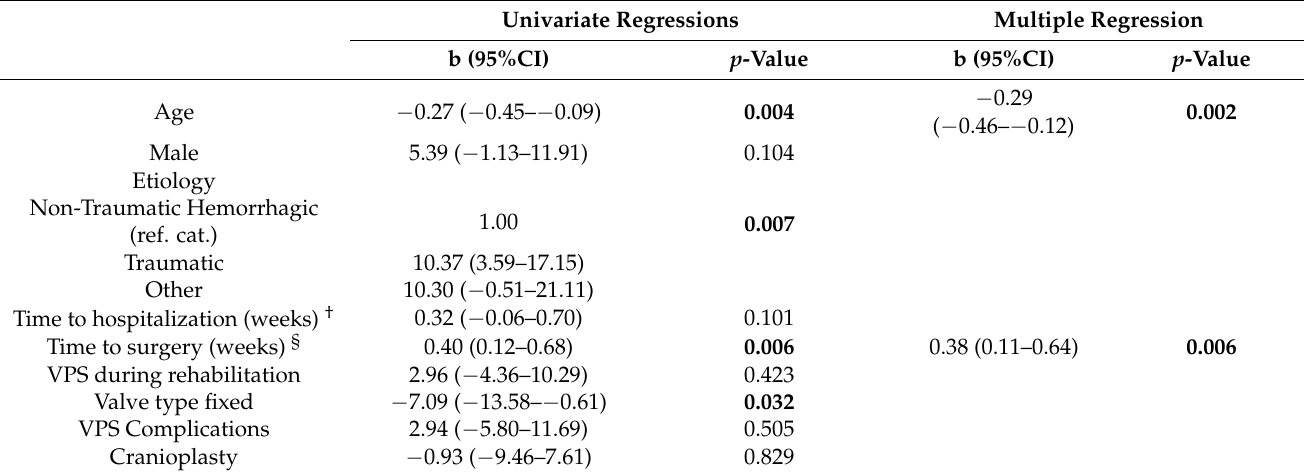
Table 3. Factors associated with LOS (weeks): results from linear univariate and multiple regression analyses. Significant associations are shown in